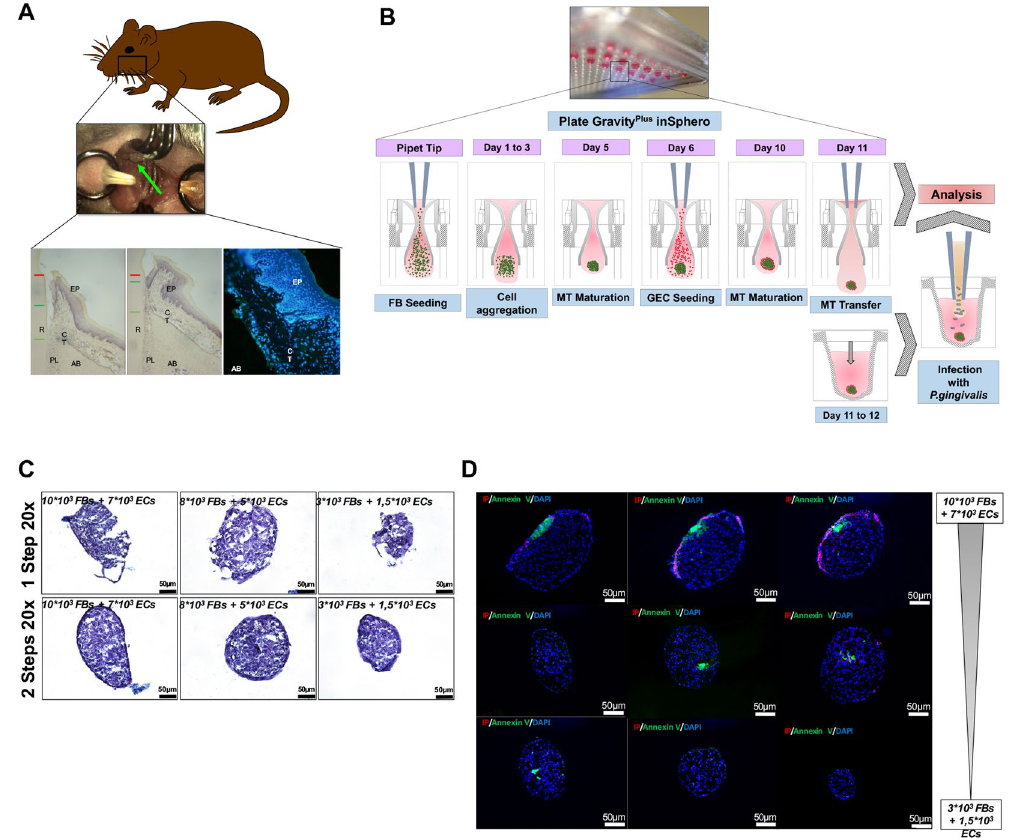
Figure 1. ( A ) Induction of experimental periodontitis. P. gingivalis infected ligatures were placed along the cervical margins on palatal sides of the maxillary first and second molars as described by Saadi-Thiers et al . 32 . ( B ) Microtissue spheroids formation diagram. Firstly, FBs were seeded in a droplet of culture medium for 5 days. After the formation of a spheroid, ECs were seeded over it. After 5 more days, two-cell types MTs were constituted. During all this procedure, cell culture medium was changed every 2 days. ( C ) Morphological characteristics of 1-Step and 2-Steps cell culture technique for MT spheroids. Three different cell concentrations (10 × 10 3 FBs + 7 × 10 3 ECs/8 × 10 3 FBs + 5 × 10 3 ECs/3 × 10 3 FBs + 1.5 × 10 3 ECs) were tested. In the 1-step procedure, both cell types were seeded simultaneously in a droplet while for the 2-steps procedure, each cell type was seeded in a time-specific manner. ( D ) Apoptosis quantification. Annexin V/IP staining of MTs at different cell concentrations showed a slight increase of cell death mainly located at the core of the MT, especially, in the biggest